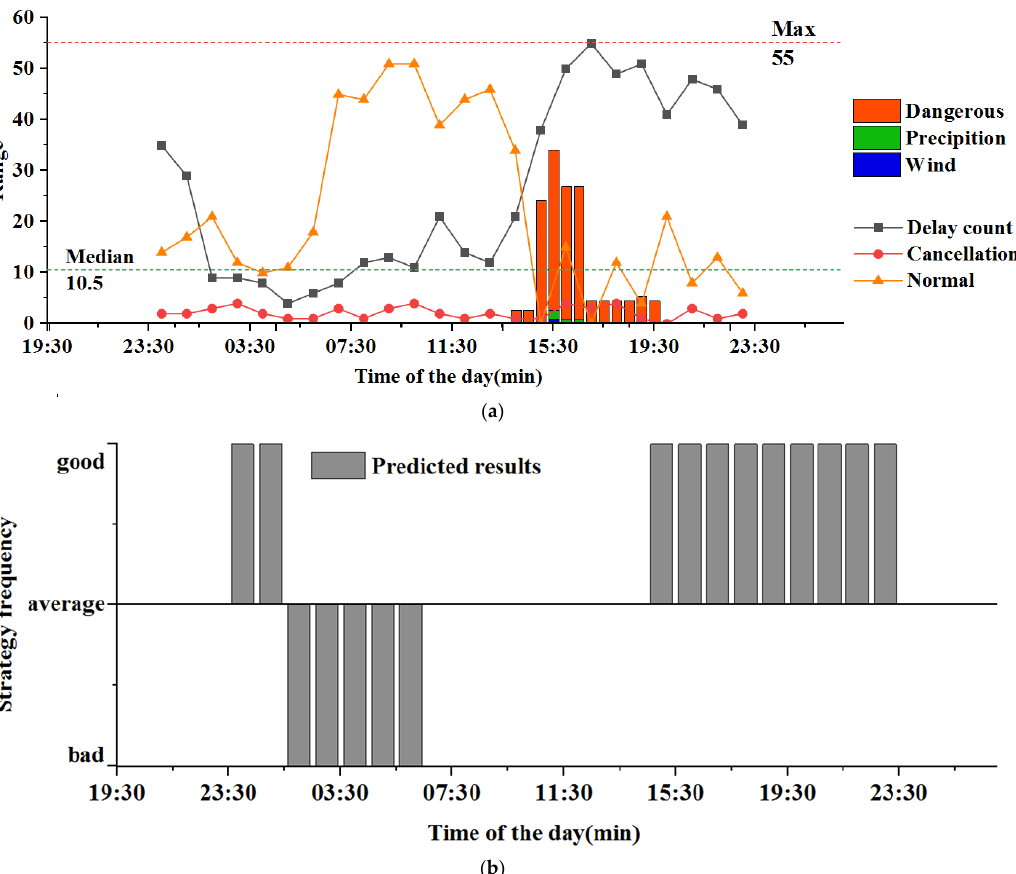
Figure 4. Feature combination 1 traffic situation changes throughout the day. ( a ) Feature Combination 1 Changes in weather and traffic features, 00:00 – 24:00 on 7 August 2018. ( b ) Traffic situation change for feature combination 1, 00:00 – 24:00 on 7 August 2018.